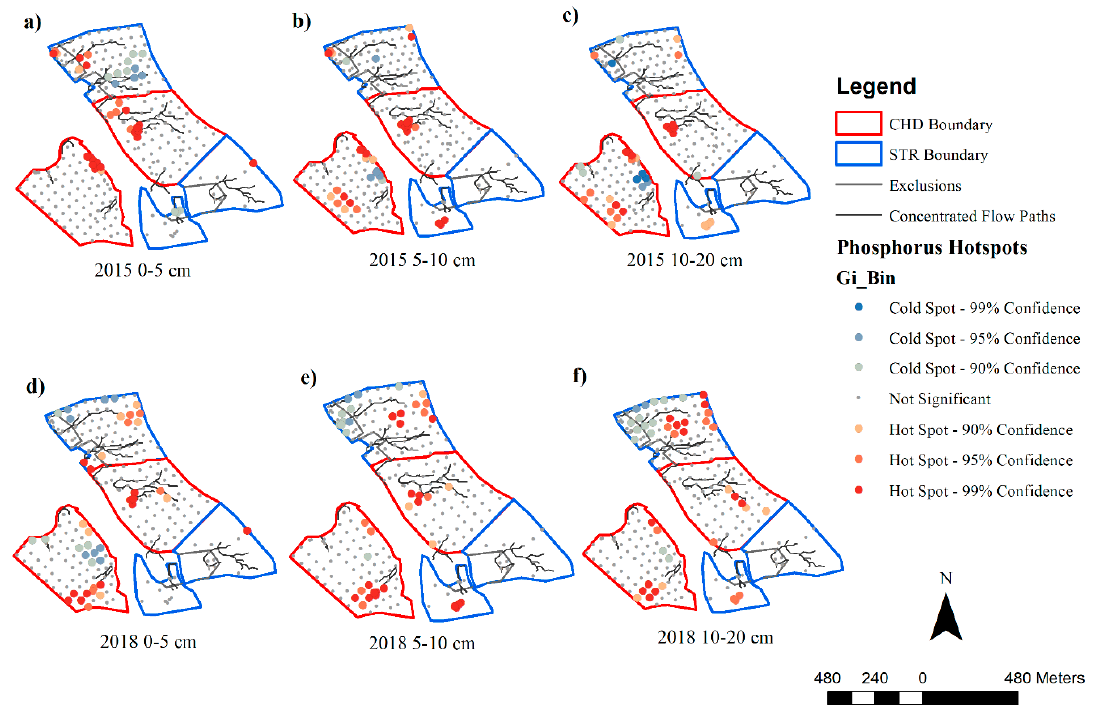
Figure 3. Hotspots of Mehlich-1 phosphorus (M1P) concentrations at 0–5, 5–10, and 10–20 cm soil depths during Baseline sampling (2015; ( a – c )) and Post-Treatment (2018; ( d – f )) at the Watkinsville pastures.